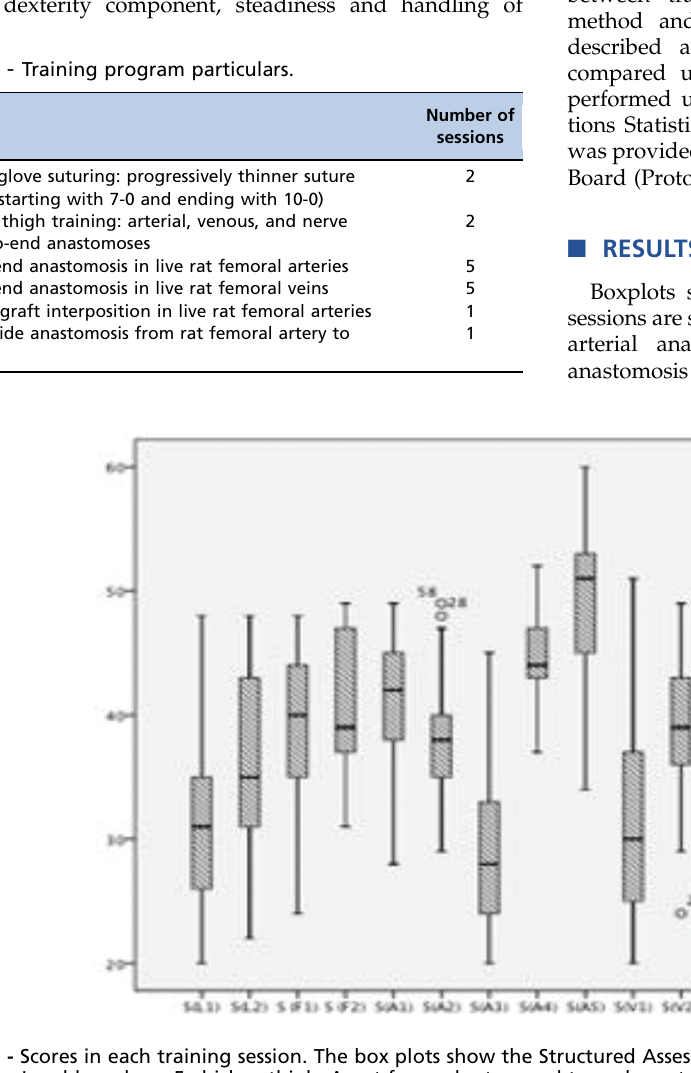
Figure 1 - Scores in each training session. The box plots show the Structured Assessment of Microsurgery Skills scores of each session. S, session; L, rubber glove; F, chicken thigh; A, rat femoral artery end-to-end anastomosis; V, rat femoral vein end-to-end anastomosis; E, graft; TL, end-to-side